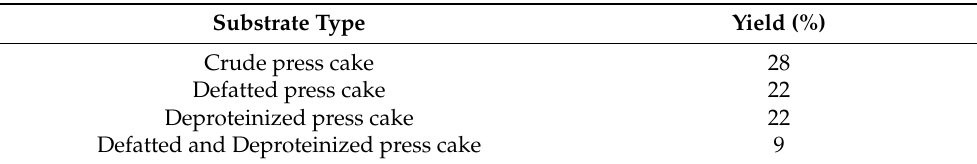
Table 2. Yields of bioplastic film matter generated from different type of substrates. Reaction conditions: 10 g of 600 µ m rapeseed cake; 100 mL of formic acid with 4–5 drops of H 2 SO 4 ; stirred at 60 ◦ C for 30 min.